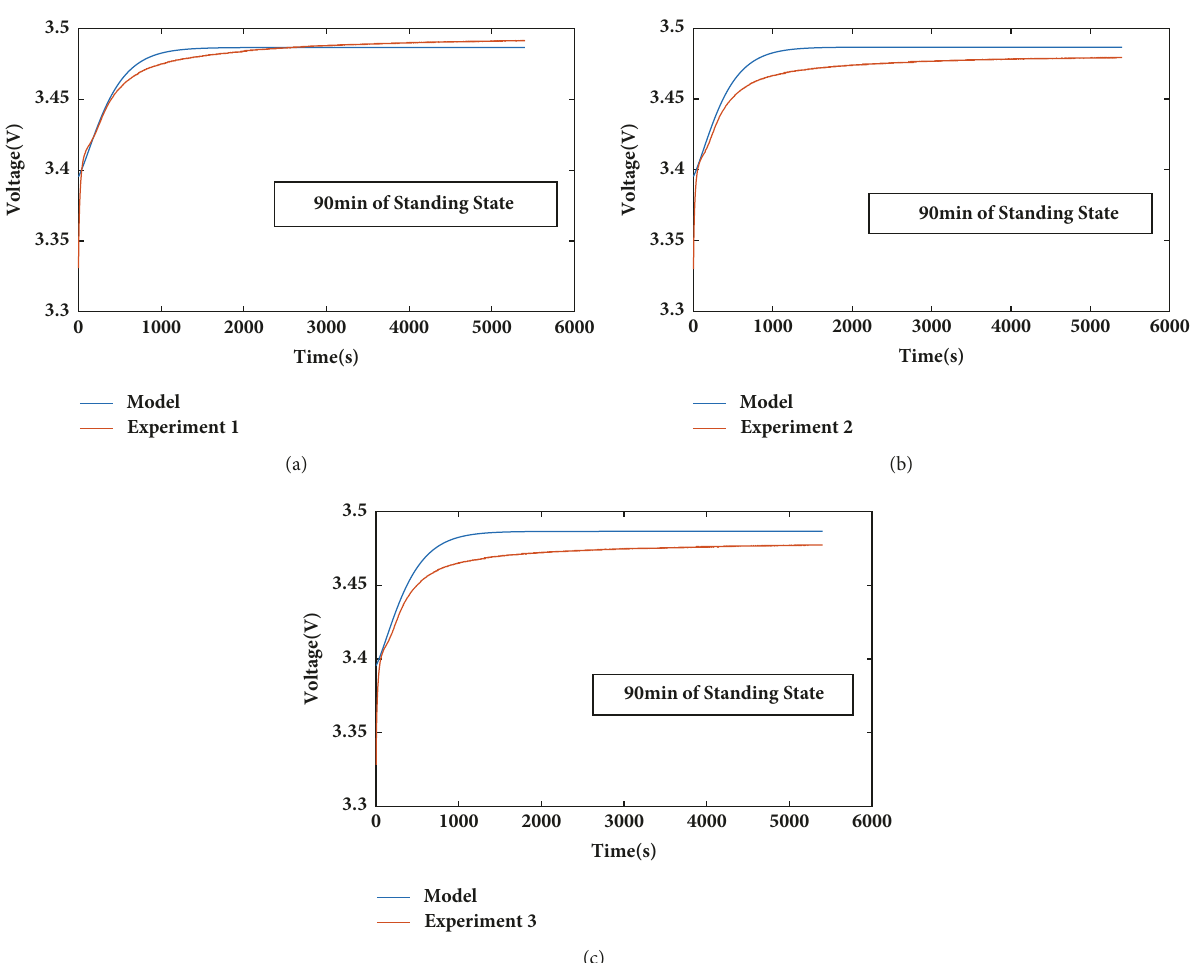
Figure 11: Comparison of model simulations and measurements at self-healing time of 90 minutes, (a) experiment 1, (b) experiment 2, and (c) experiment 3.